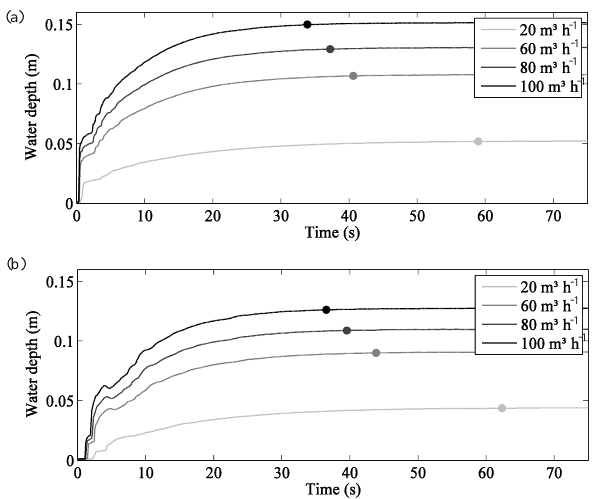
Figure 17. Computed water depths in the unsteady simulations, at the intersections (a) between streets 1 and A, and (b) between streets 4 and C. The markers ( • ) indicate the moment when the wa- ter depth reaches 99% of its ultimate